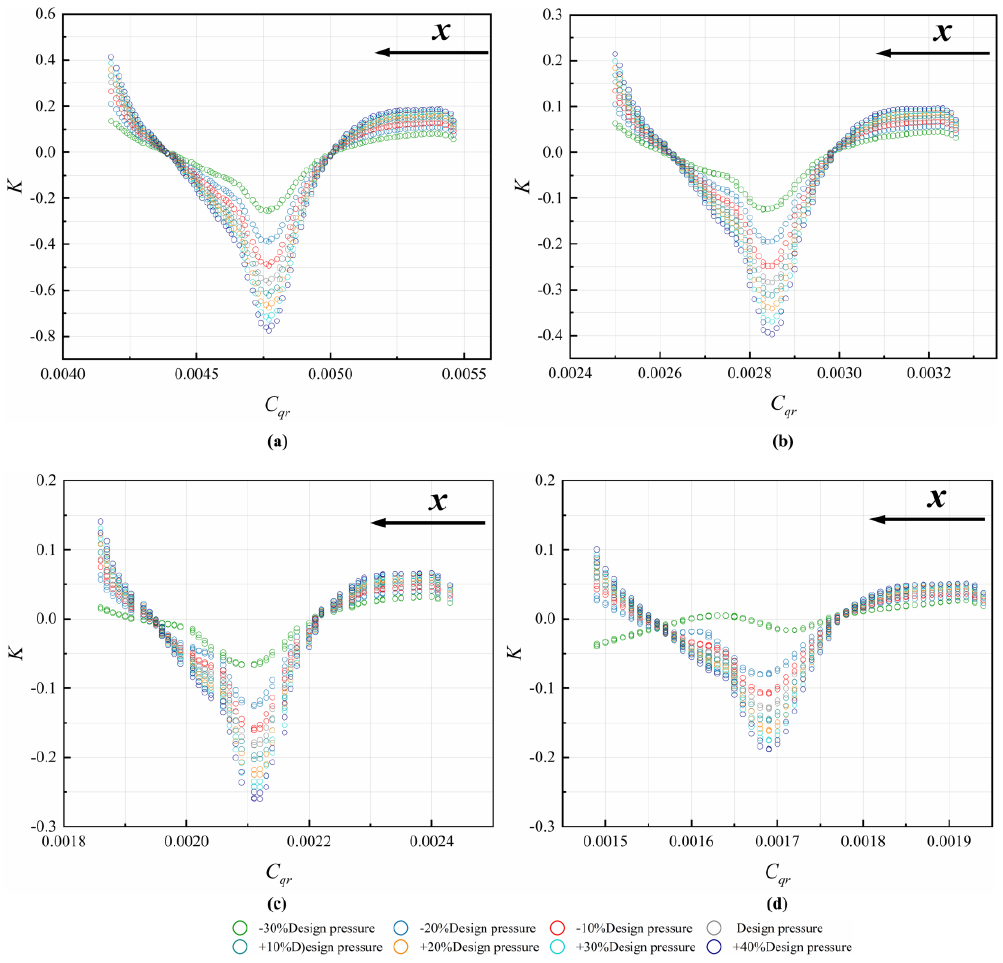
Figure 4. Radial distribution of core swirl ratio in C1 cavity at different Re : ( a ) Re = 2.3793 × 10 5 , ( b ) Re = 4.7586 × 10 5 , ( c ) Re = 7.1379 × 10 5 , and ( d ) Re = 9.5172 × 10 5 .